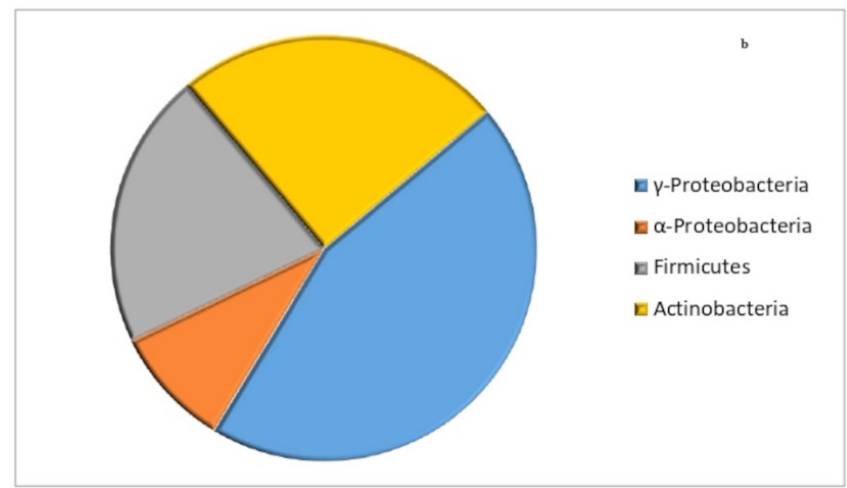
Figure 3. ( a ) Phylogenetic tree based on partial 16S rRNA gene sequence showing the relationship among various bacterial isolates obtained from pearl millet during the entire growth period of the plant. Bootstrap values greater than 50 are indicated at the corresponding nodes. ( b ) Pie-diagram showing different classes of bacteria isolated during the present study.